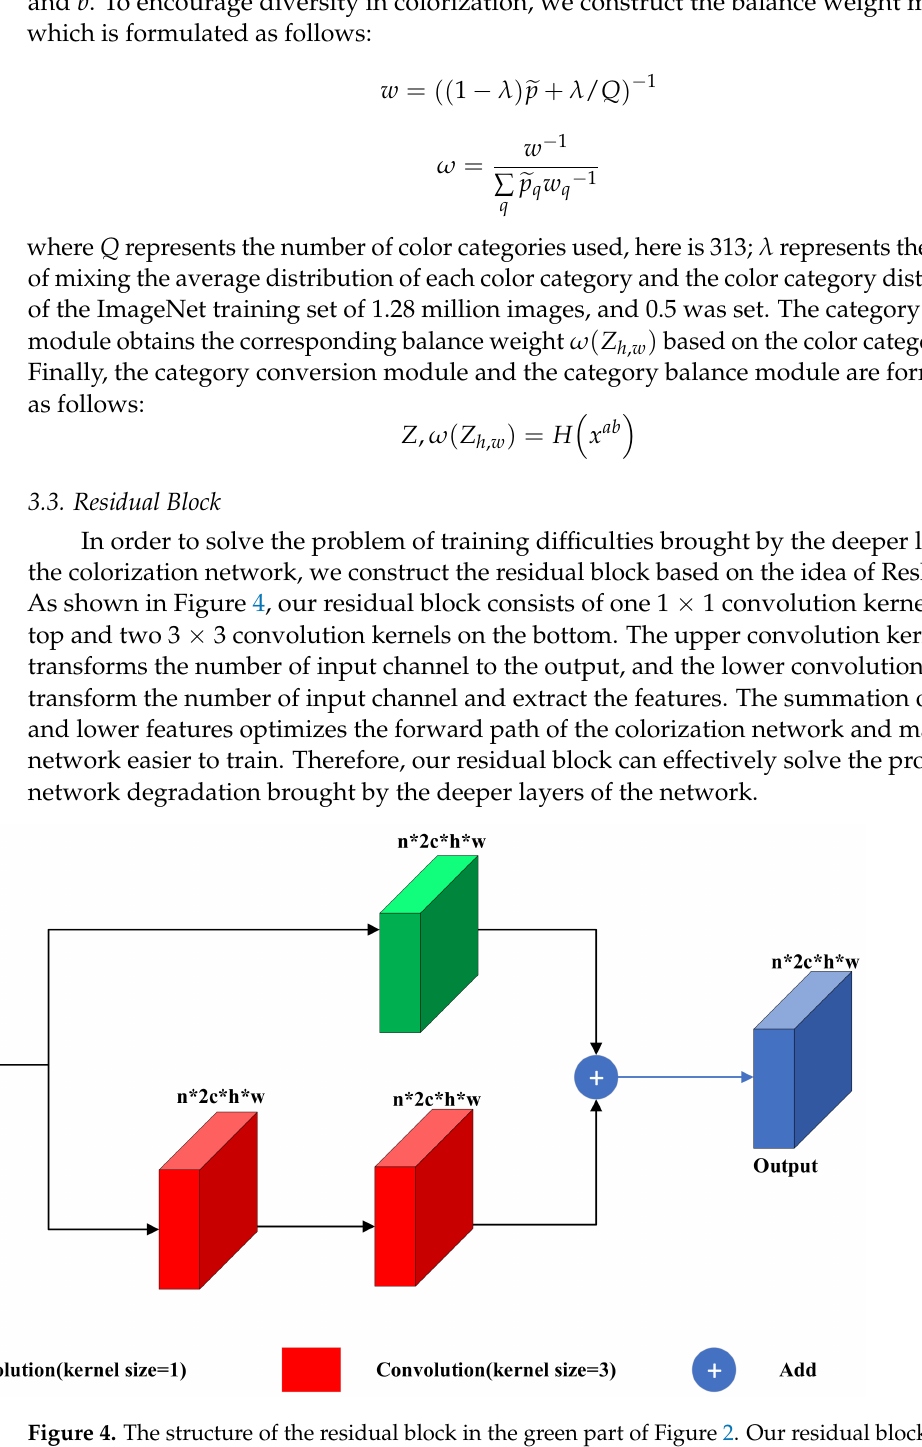
Figure 4. The structure of the residual block in the green part of Figure 2. Our residual block consists of one 1 × 1 convolution kernel and two 3 × 3 convolution